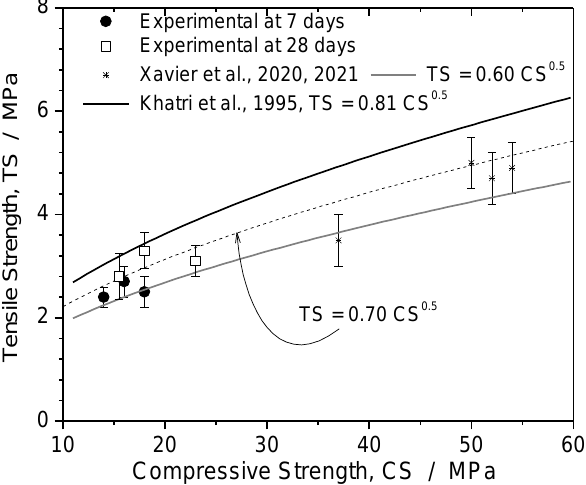
Figure 3. Correlation between tensile and compressive strengths demonstrating TS = k CS 0.5 , consid- ering 7 and 28 days of curing.